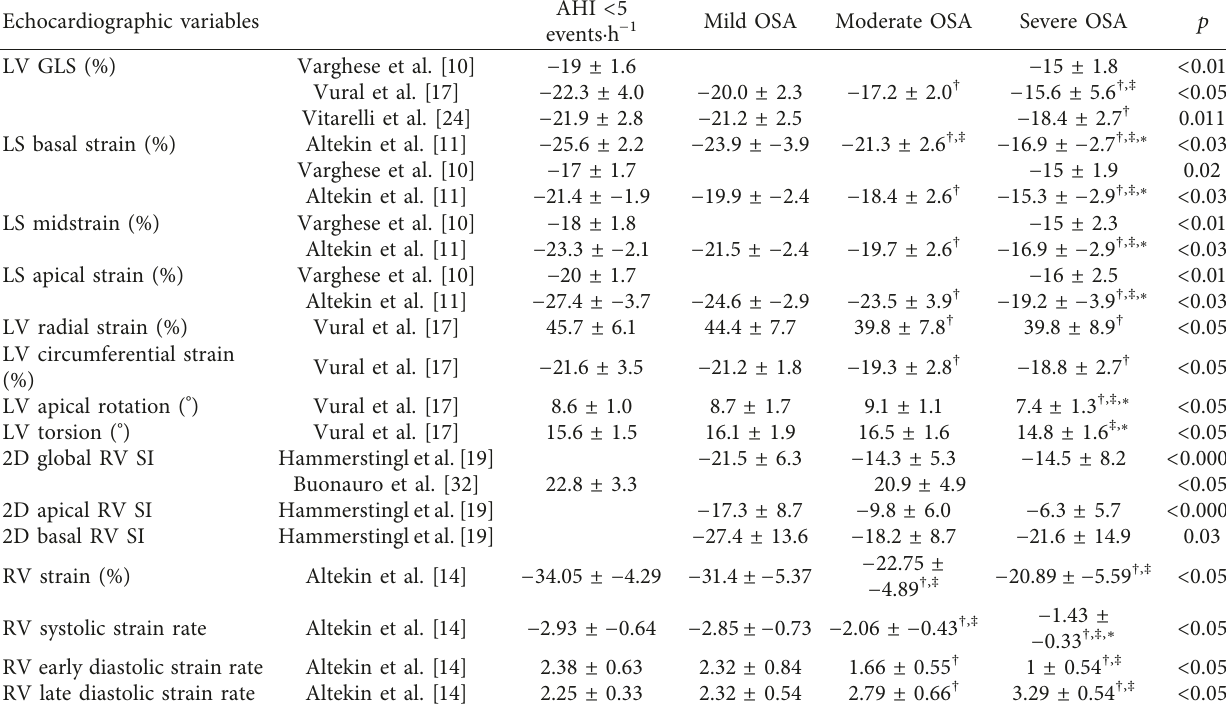
Table 9: Left and right ventricular strain parameters in subjects with OSA.